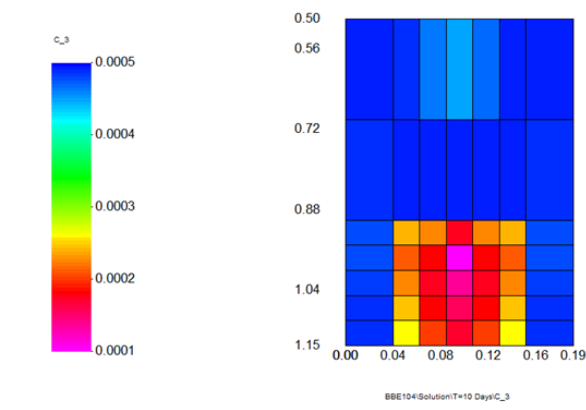
Figure 7: Surfactant concentration (volume fraction) after 10 days of imbibition. The vertical XZ cross section through the center (at Y-slice=4) of the model.